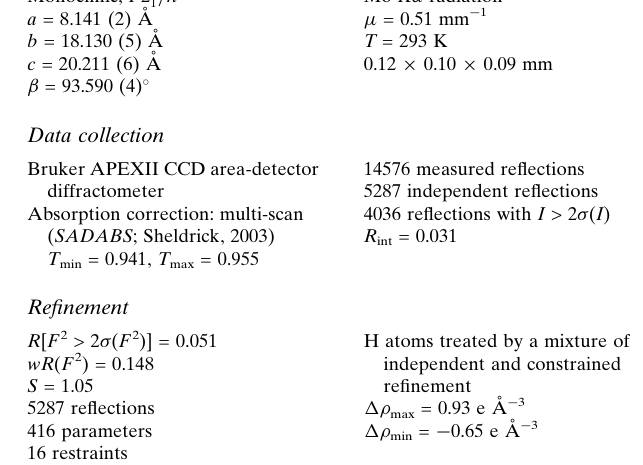
Bruker APEXII CCD area-detector diffractometer